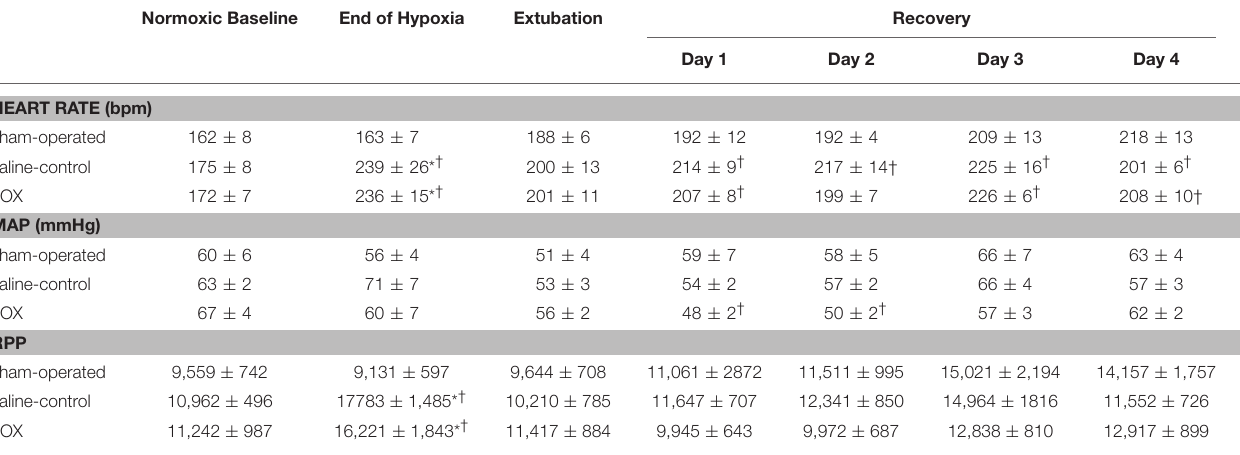
TABLE 2 | Temporal changes in heart rate, mean arterial pressure (MAP) and rate-pressure-product (RPP) during hypoxia and recovery. Normoxic Baseline End of Hypoxia